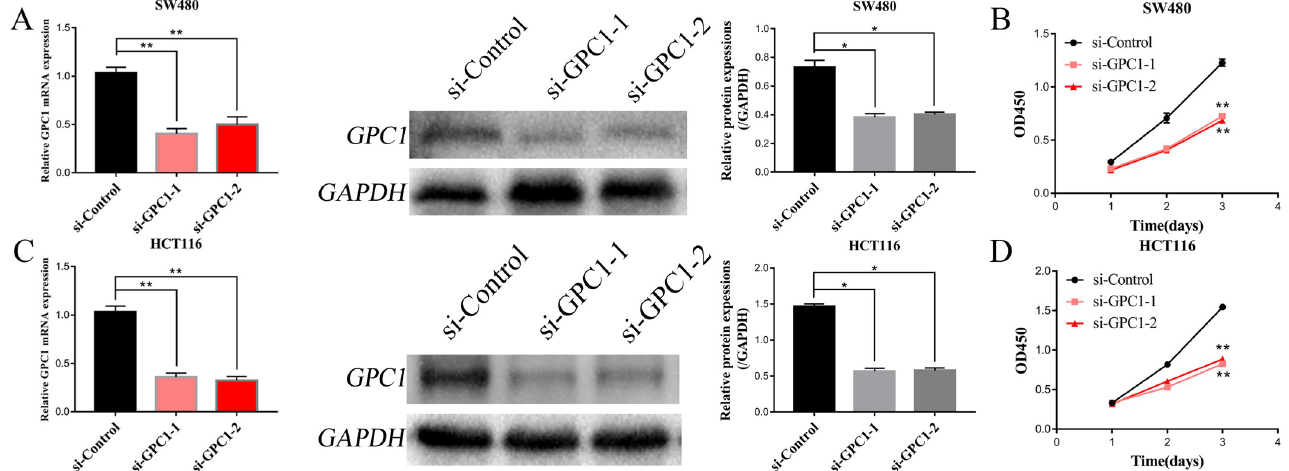
Fig 3. Silencing GPC1 inhibits CRC cell proliferation. (A, C). CRC cell lines were transfected with siRNA targeting GPC1, and silencing efficiency at the mRNA and protein levels was determined. (B, D). Cell proliferation was inhibited in SW480 and HCT116 cells by silencing GPC1. � p < 0.05, �� p < 0.01.